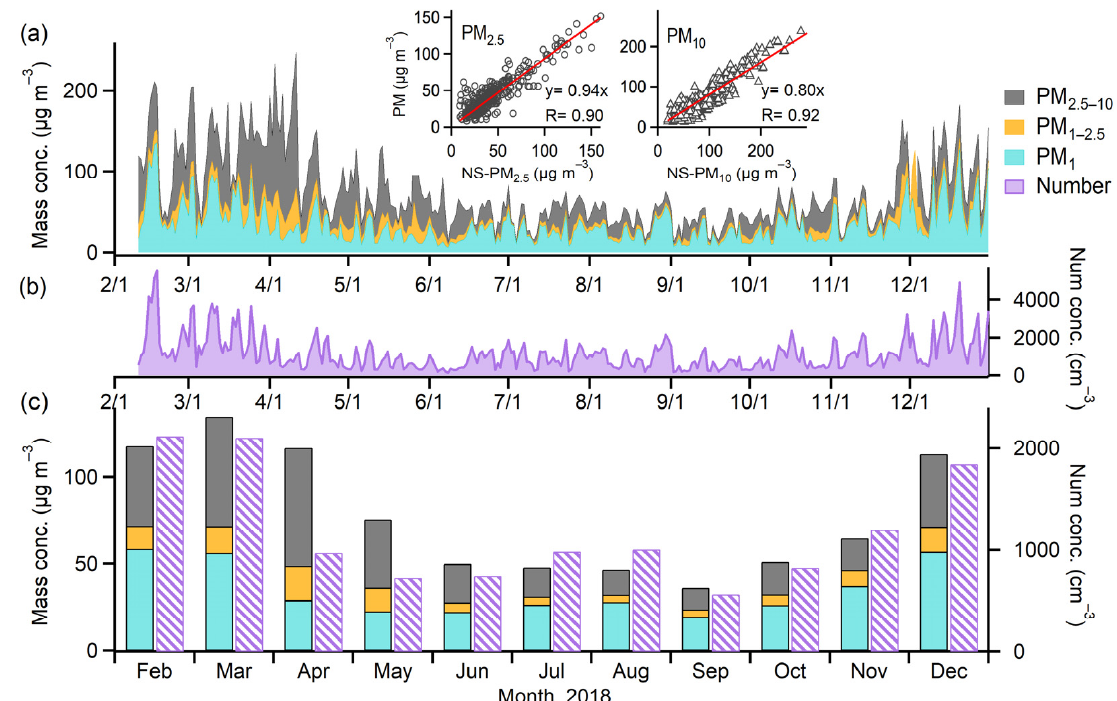
Figure 1. Temporal variations of the ( a ) mass and ( b ) number concentrations of PM at daily resolution and ( c ) the monthly mean PM concentrations over the studied period. The two small panels in ( a ) present the correlations of PM 2.5 and PM 10 mass concentrations measured by the EDM-180 particle monitor and those obtained from the national air quality monitoring station.